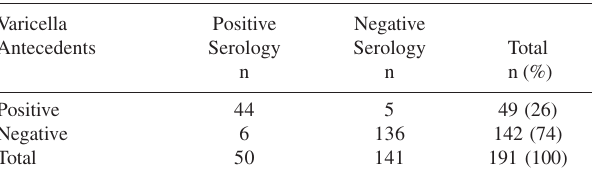
Table 3 - Distribution of children* (n) whose parents claimed to be sure about varicella antecedents. Distribution according to serologic tests. São Paulo Municipality, August 2003 to